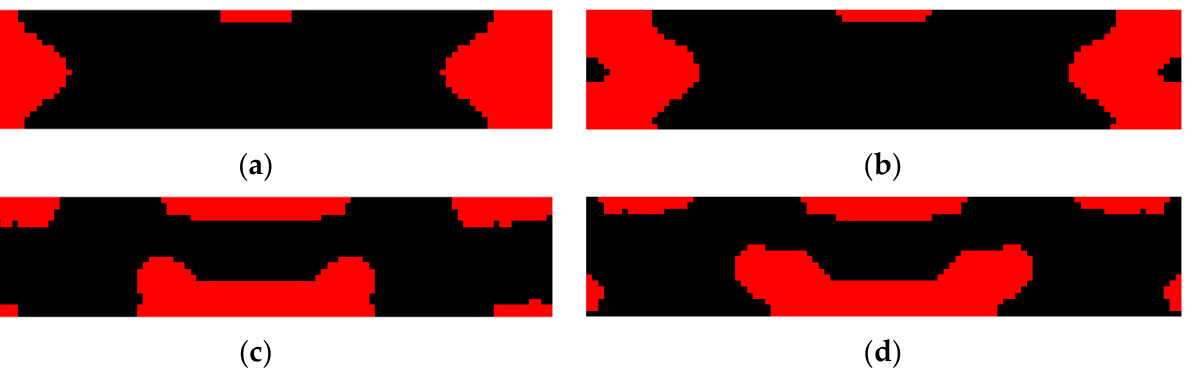
Table 1. The FEM analysis results of the energy conversion efficiency and open ‐ circuit voltage.